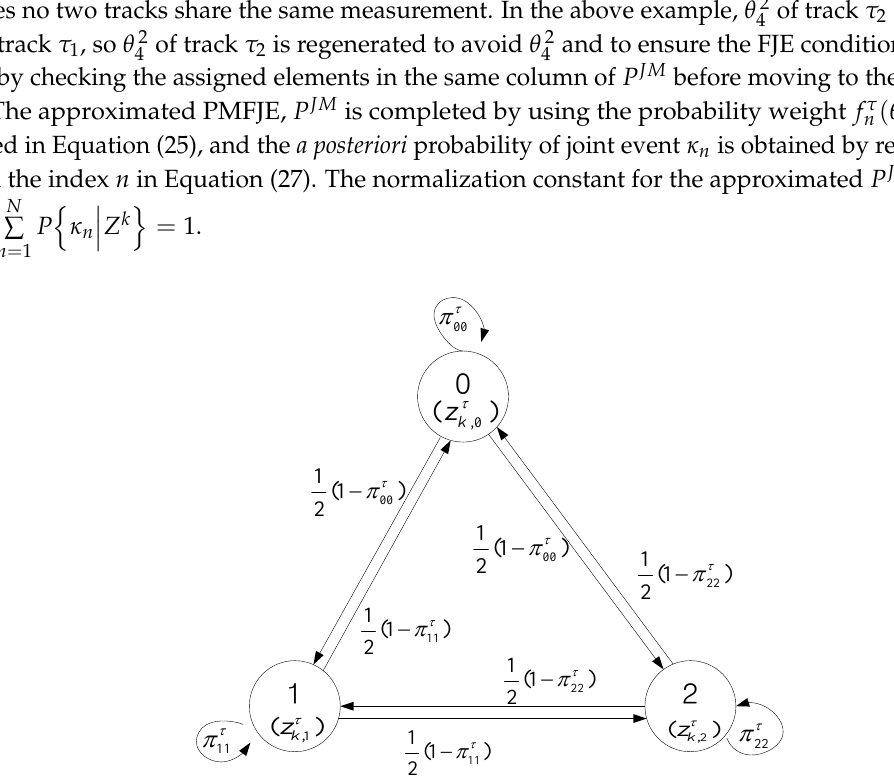
Figure 2. An example of a three-state Markov chain for track τ with two measurements. for T cluster tracks is obtained, the { } N After the Markov chain track sequences, 1 n approximated PMFJE JM P is completed. From the approximated JM P , the track to measurement and association probabilities o i